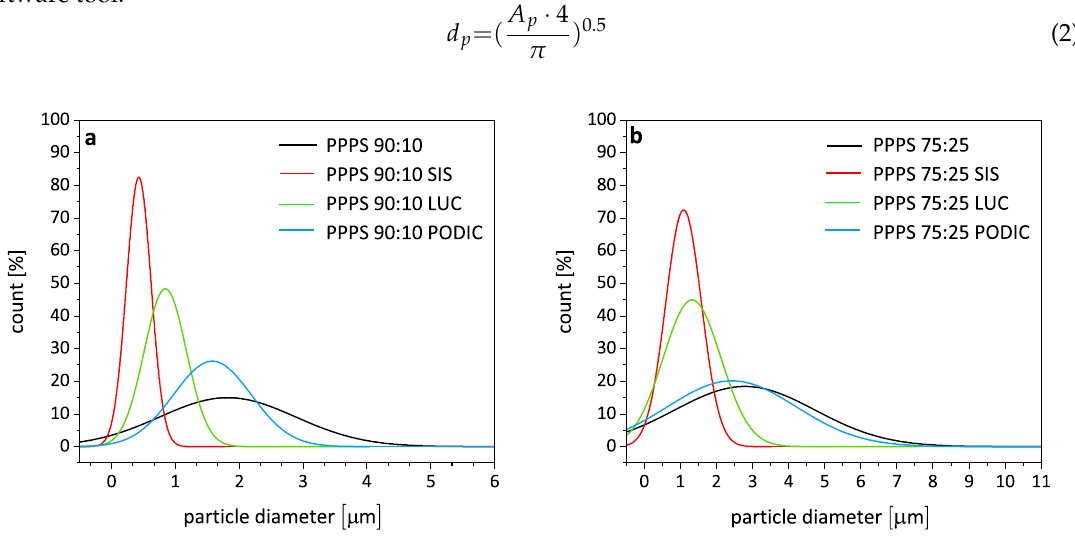
Figure 11. Normal distributions for calculated particle diameters of PP–PS 90:10 ( a ) and PP–PS 75:25 ( b )